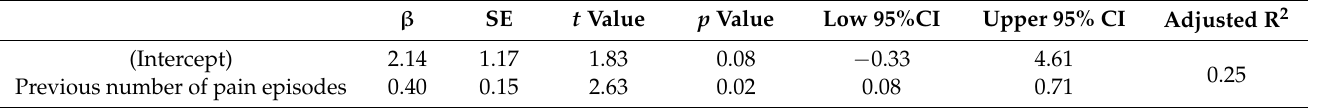
Table 8. Results of multivariate regression analysis showing associations between baseline predictors and number of days with pain (average of 12